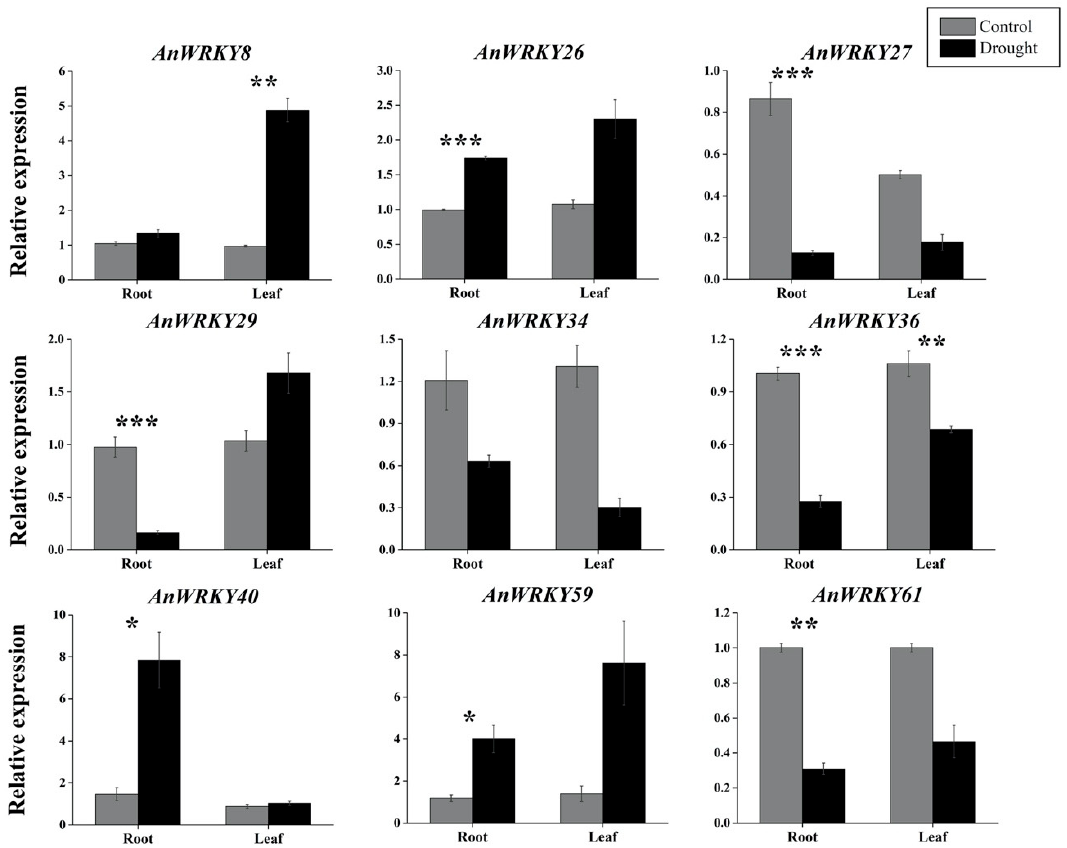
Figure 5. qRT-PCR assays of the expression of AnWRKY8 , 26 , 27 , 29 , 34 , 36 , 40 , 59 , and 61 in response to drought in roots and leaves. Black columns show data for the six-day drought treatment, and the gray columns show data for the controls. AnACTIN2 was used as an internal control. The mean and SE were derived from three biological and three technical replicates. *** p < 0.001, ** p < 0.01, * p < 0.05, Student’s t -test.